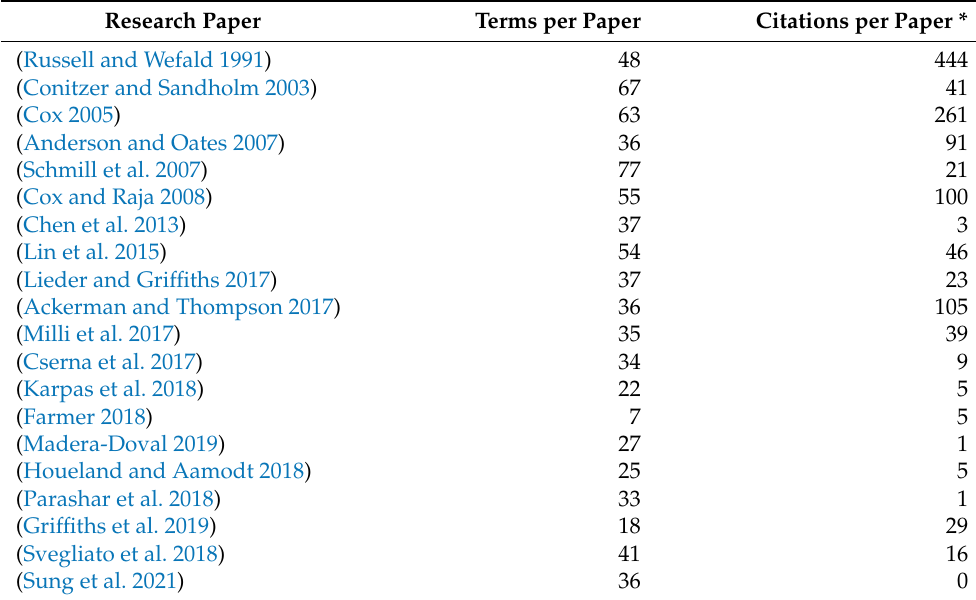
Table 2. Papers reviewed for the stage of gathering information, knowledge acquisition and concep-